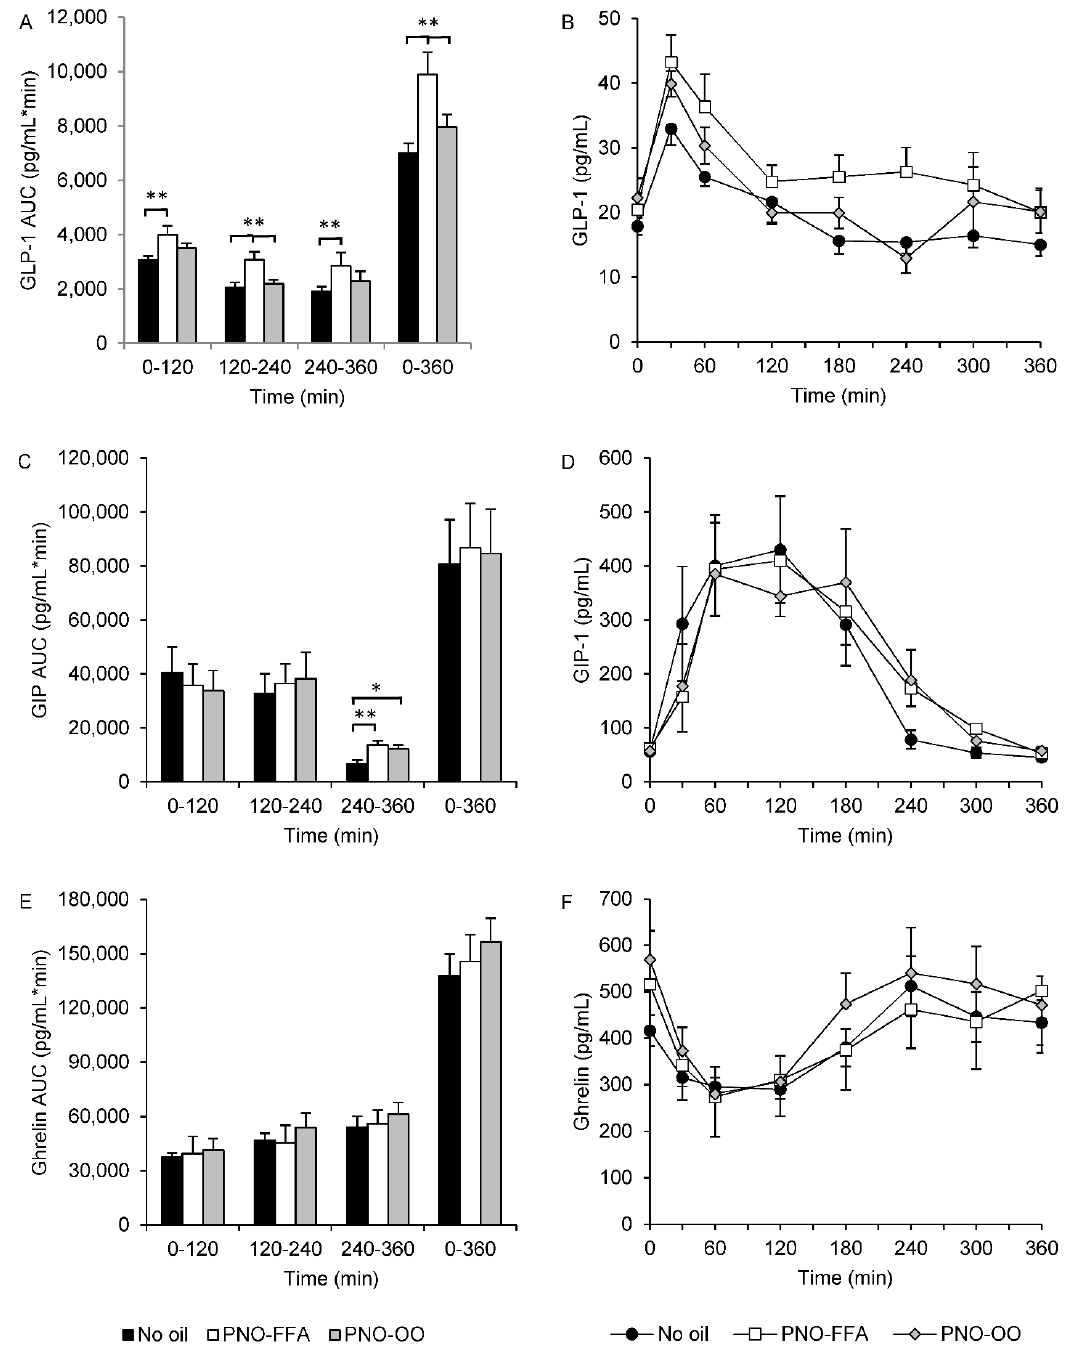
Figure 2. GLP-1 ( A , B ), GIP ( C , D ) and ghrelin ( E , F ) levels during a 6-h OGTT and their corresponding area under the curve calculated for 0–120, 120–240, 240–360 and 0–360 min in response to glucose alone (no oil, black bars and black circles), 6 g hydrolyzed pine nut oil (PNO-FFA, white bars and white squares) or 3 g hydrolyzed pine nut oil and 3 g olive oil (PNO-OO, gray bars and gray diamonds). Data are mean ± SEM. * p < 0.05, ** p <